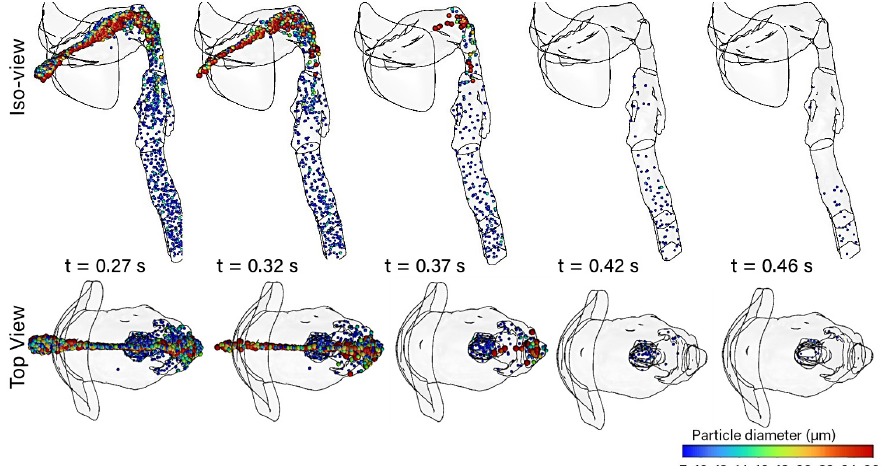
Figure 4. Isometric and top view of the mouth–throat, showing the particle trajectories at five time increments from t = 0.27 s to t = 0.46 s. The particles are colored by diameter in microns. Figure 5 shows the particle penetration of the 50 particles from their initial location. Highlighted in this figure is the difference in time (x-axis) for particles to reach their terminal velocity. Some of the particles furthest away at a distance of 0 to 0.02 mm had not moved in the first 0.07 s of the 0.5 s inhalation, while the particles closest to the inlet quickly reached their terminal velocity within the first 0.07